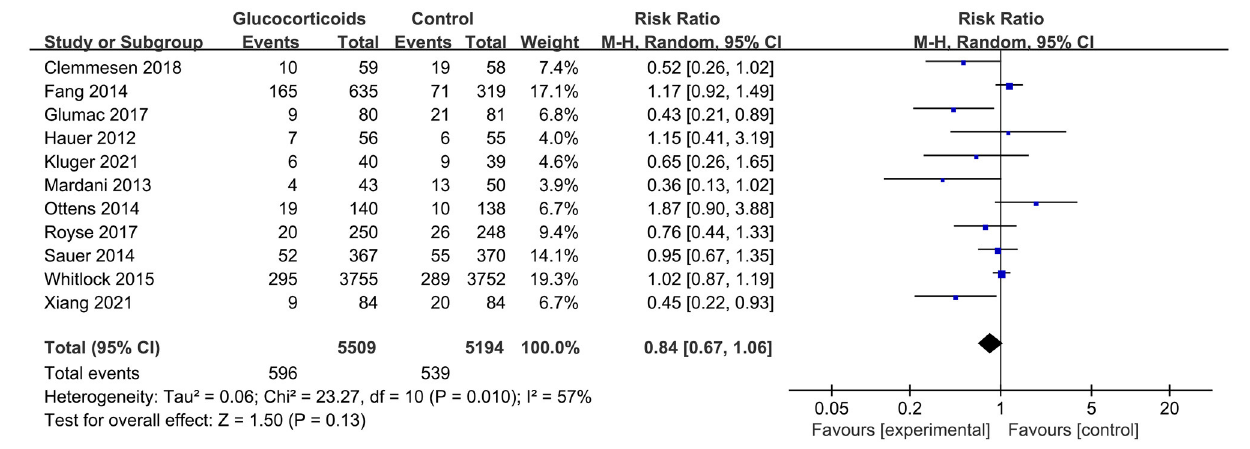
FIGURE 3 | Forest plot for the incidence of